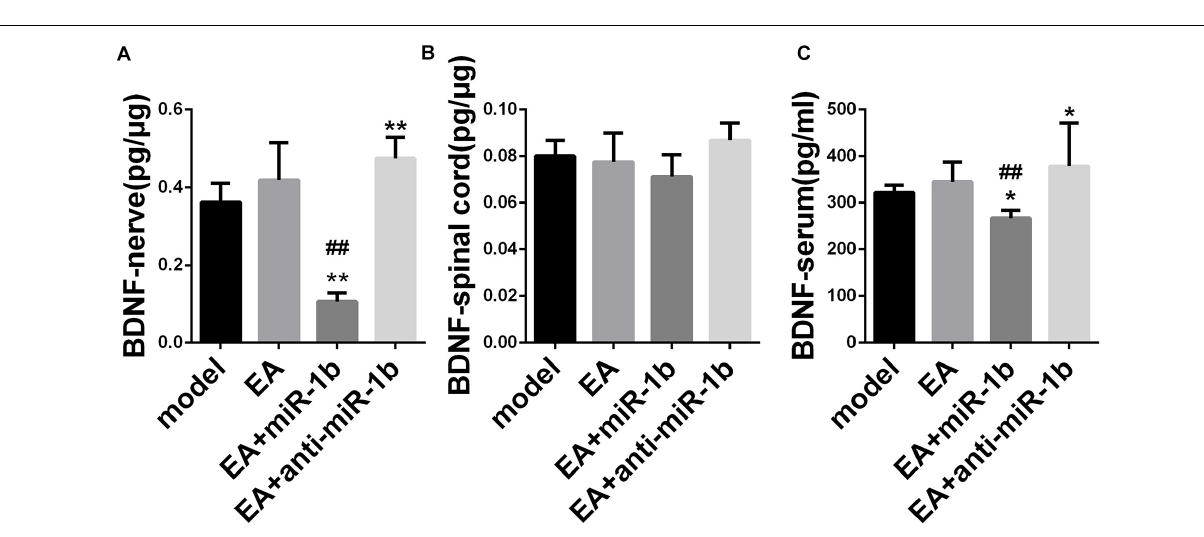
FIGURE 5 | EA increased the expression of BDNF by downregulating miR-1b in injured sciatic nerve and serum. The expression of BDNF expression in the injured sciatic nerve (A) , ipsilateral spinal cord (B) , and in serum (C) was detected by ELISA. * P < 0.05 and ** P < 0.01 versus the model group. ## P < 0.01 versus the EA